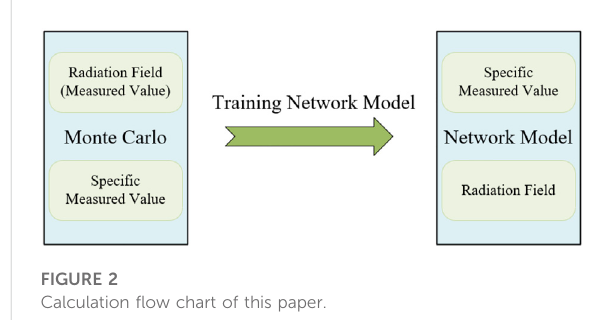
FIGURE 2 Calculation fl ow chart of this